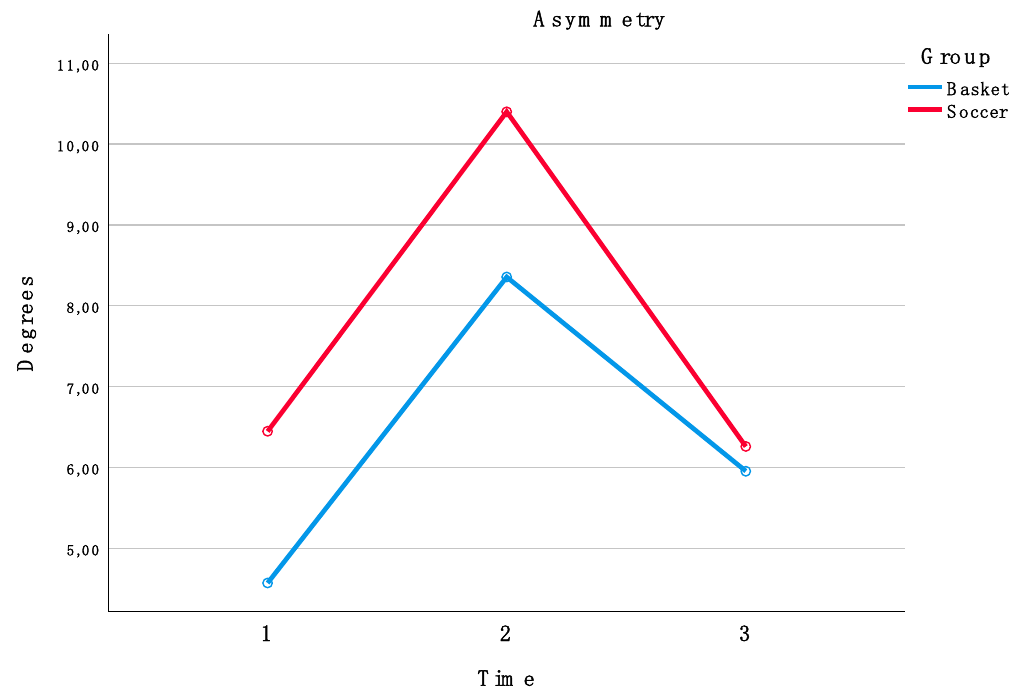
Figure 3. Asymmetry values for each group in three measurement times.